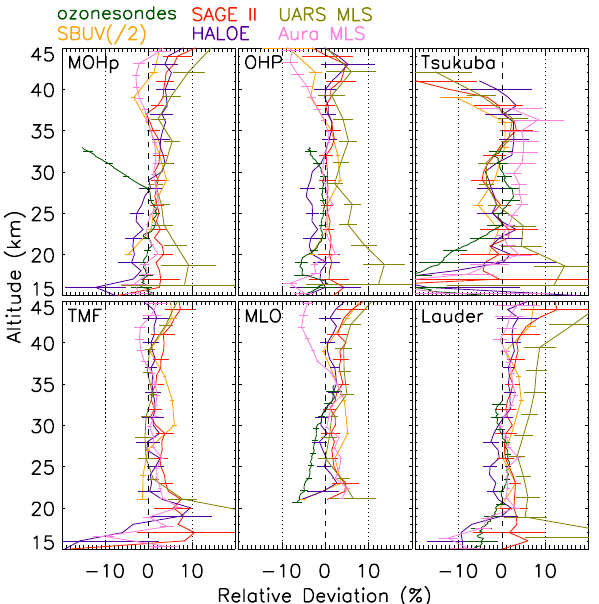
Fig. 2. Vertical distribution of the average relative differences of the coincident ozone profiles of different data sets with various lidar (cid:17)i h 1 (cid:16) 6 . The dashed and dotted measurements 100 × Meas − lidar N lidar vertical lines represent 0 and ± 10%, respectively, and the error bars correspond to twice the standard